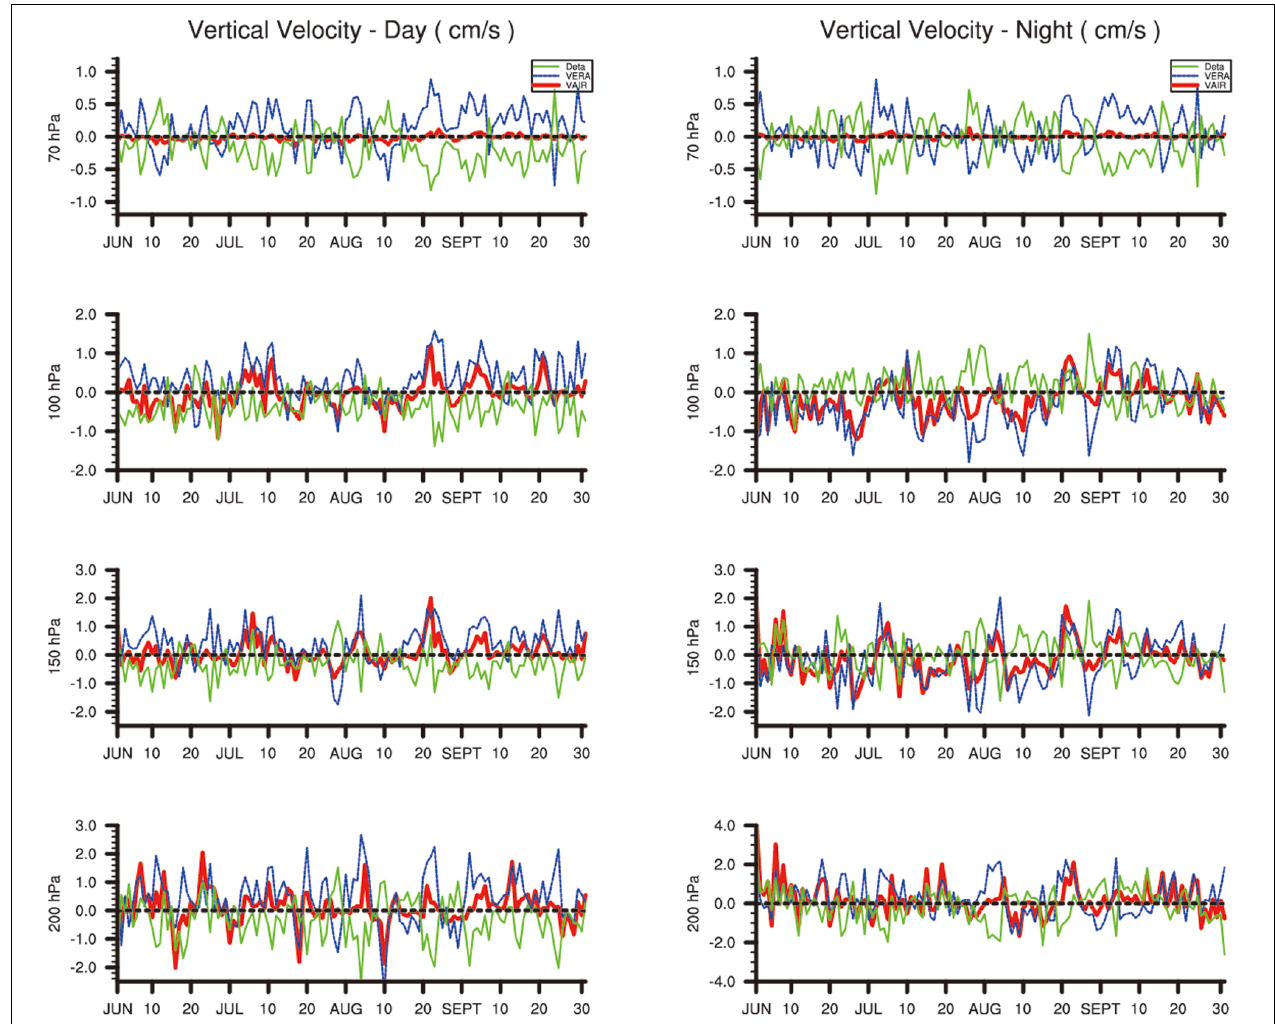
FIGURE 2 | Time series of daily vertical velocity at different pressure layers in JJAS (June–September) 2012. The red and blue lines indicate V AIRS and V ERA − I , respectively, and the green lines represent the difference between the two values. The daytime and nighttime vertical velocity are shown in the left- and right-hand panels,